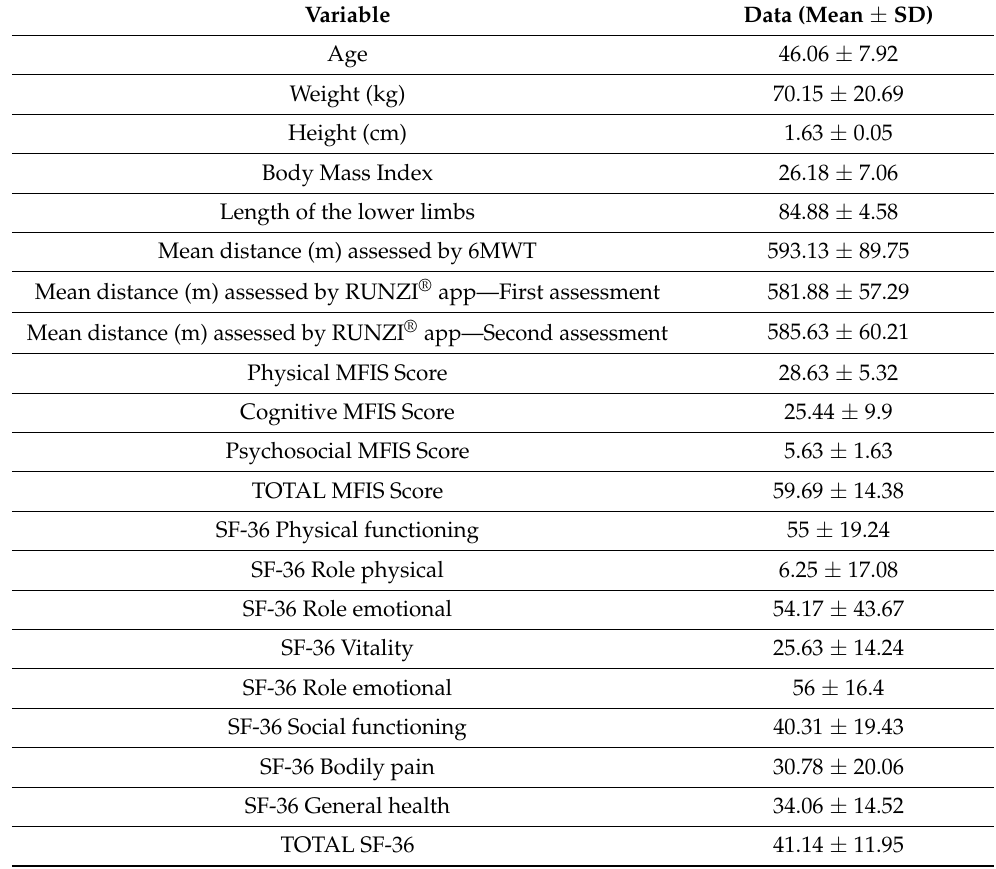
Table 1. Sociodemographic and clinical characteristics of the